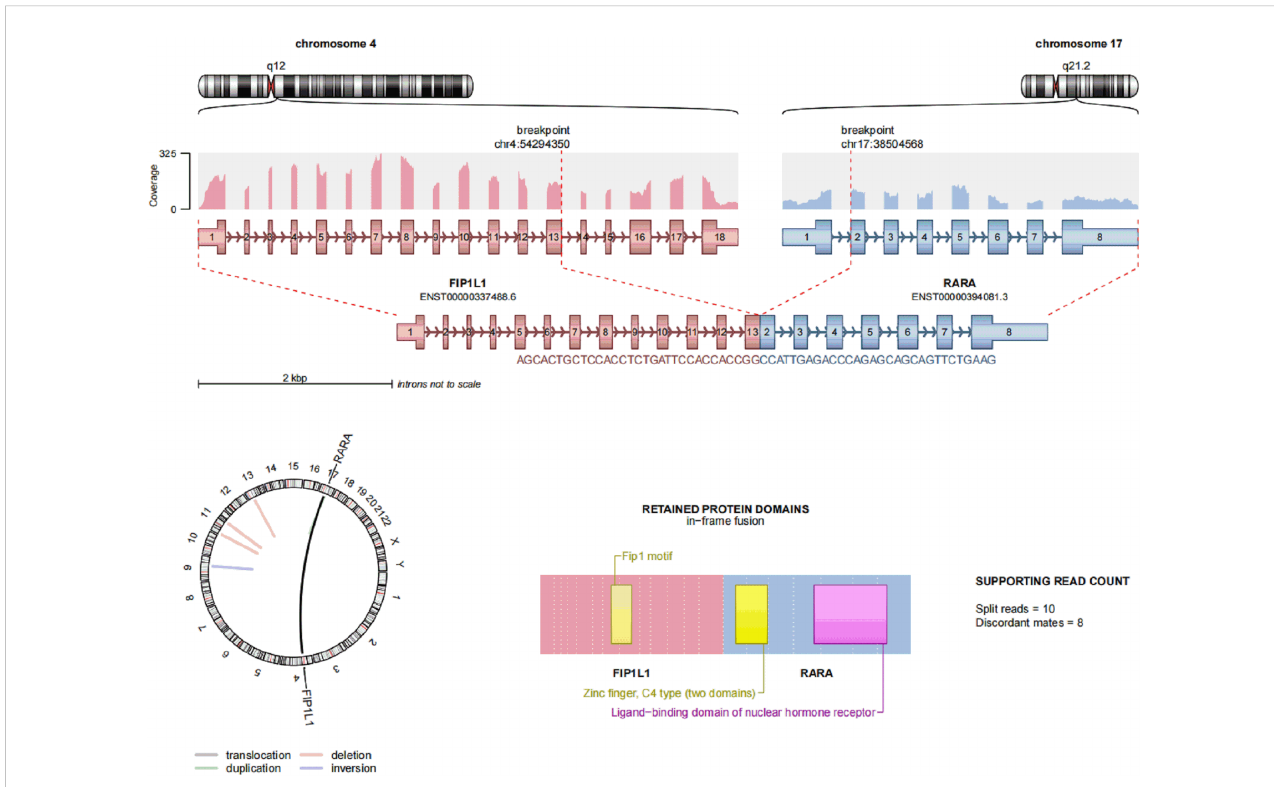
FIGURE 2 Transcriptome sequencing of FIP1L1::RARA fusion gene at onset, a fusion between exon 13 of FIP1L1 and exon 3 of RARA was identi fi